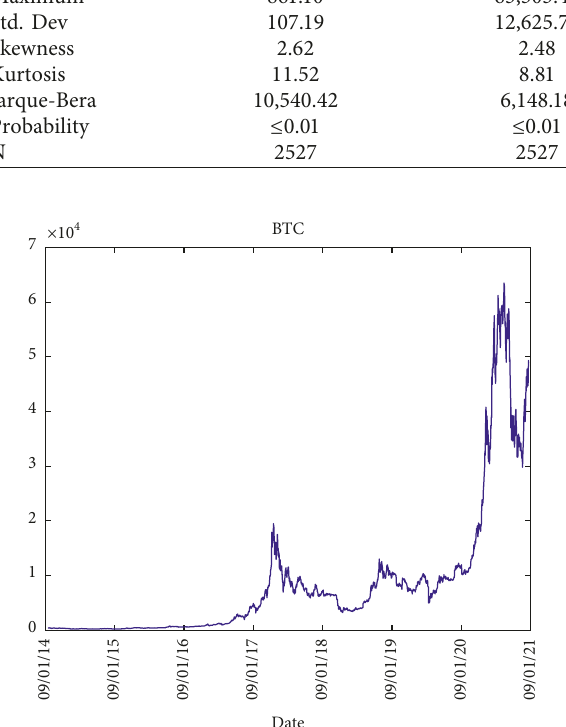
Figure 1: Evolution pattern of Bitcoin price